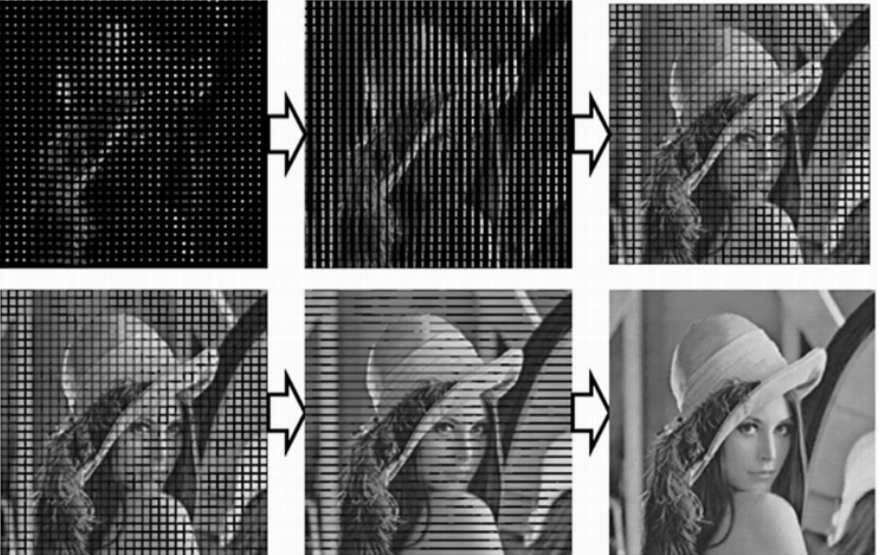
Figure 10. Bilinear interpolation and seams